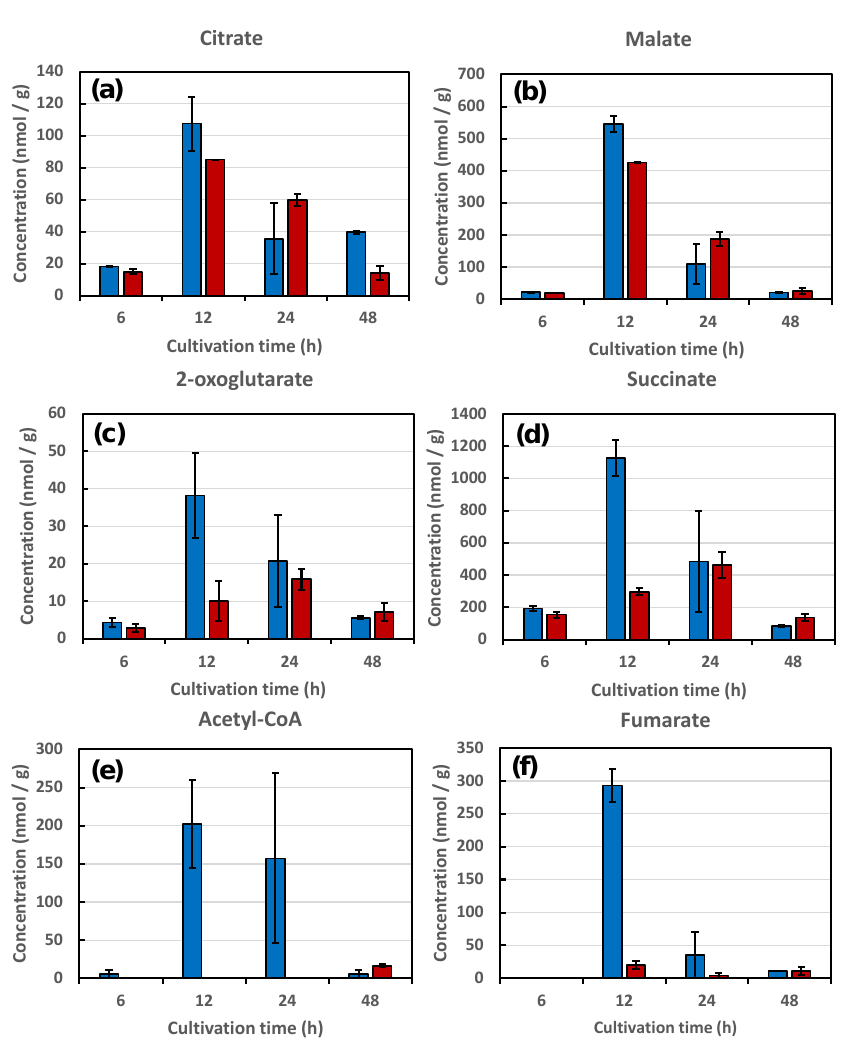
Figure 6. The concentrations of metabolites related to the TCA cycle in strains KA31a (open bars) and a924E1 (closed bars) at 6 to 48 h of cultivation. The concentration of each metabolite is shown as nmol of metabolite per gram of dry weight of yeast cells. Panels ( a – f ) show the concentrations of citrate, malate, 2-oxoglutarate, succinate, acetyl-CoA, and fumarate, respectively. Values are presented as mean ± standard deviation from three independent experiments.